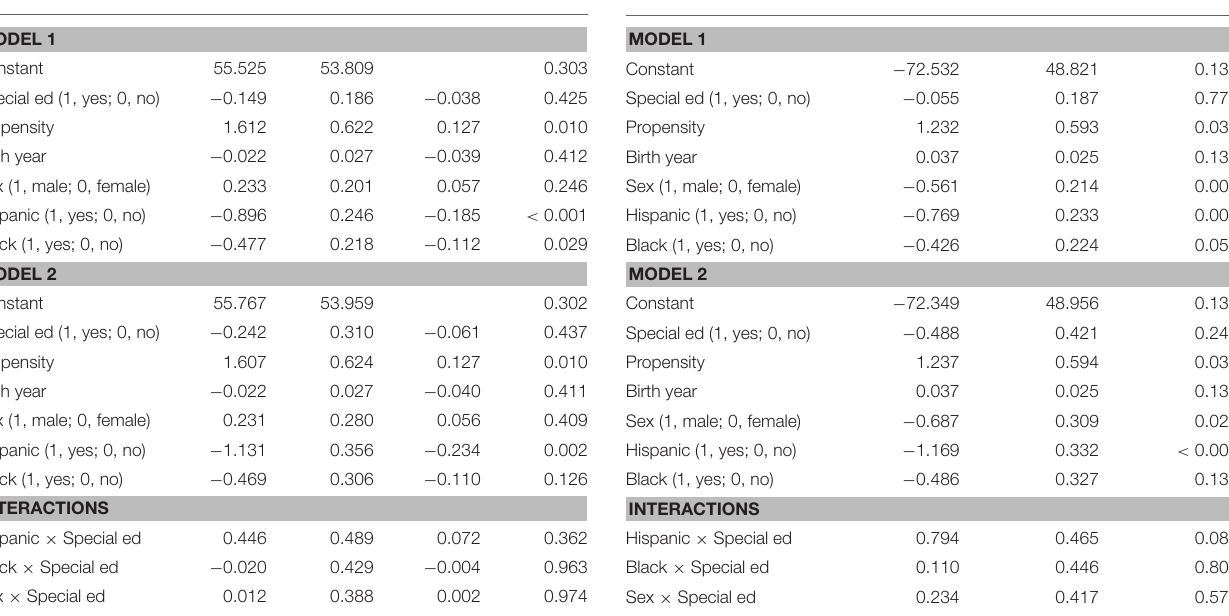
TABLE 4 | Hierarchical multiple regression analyses predicting highest grade completed ( n = 586). Predictor variables